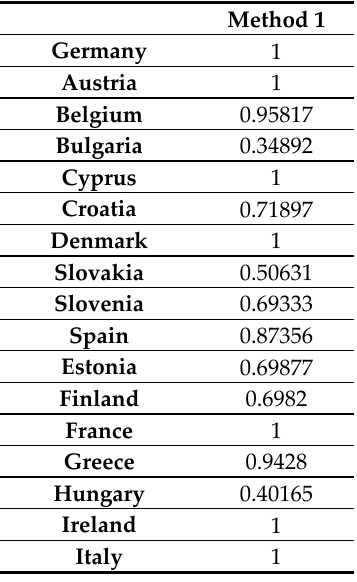
Table 4. Average environmental efficiency data for the 28 countries in the period 2005–2012 obtained with the DEA Method 1. Source: own